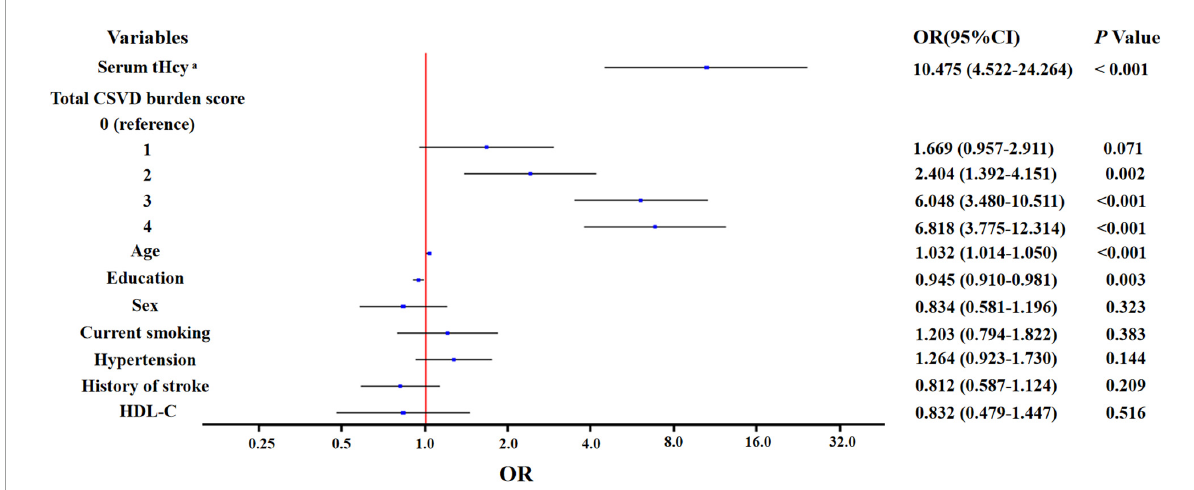
FIGURE1 Multivariate binary logistic regression analysis for the associated factors with cognitive impairment. a The variable was transformed to log scale.